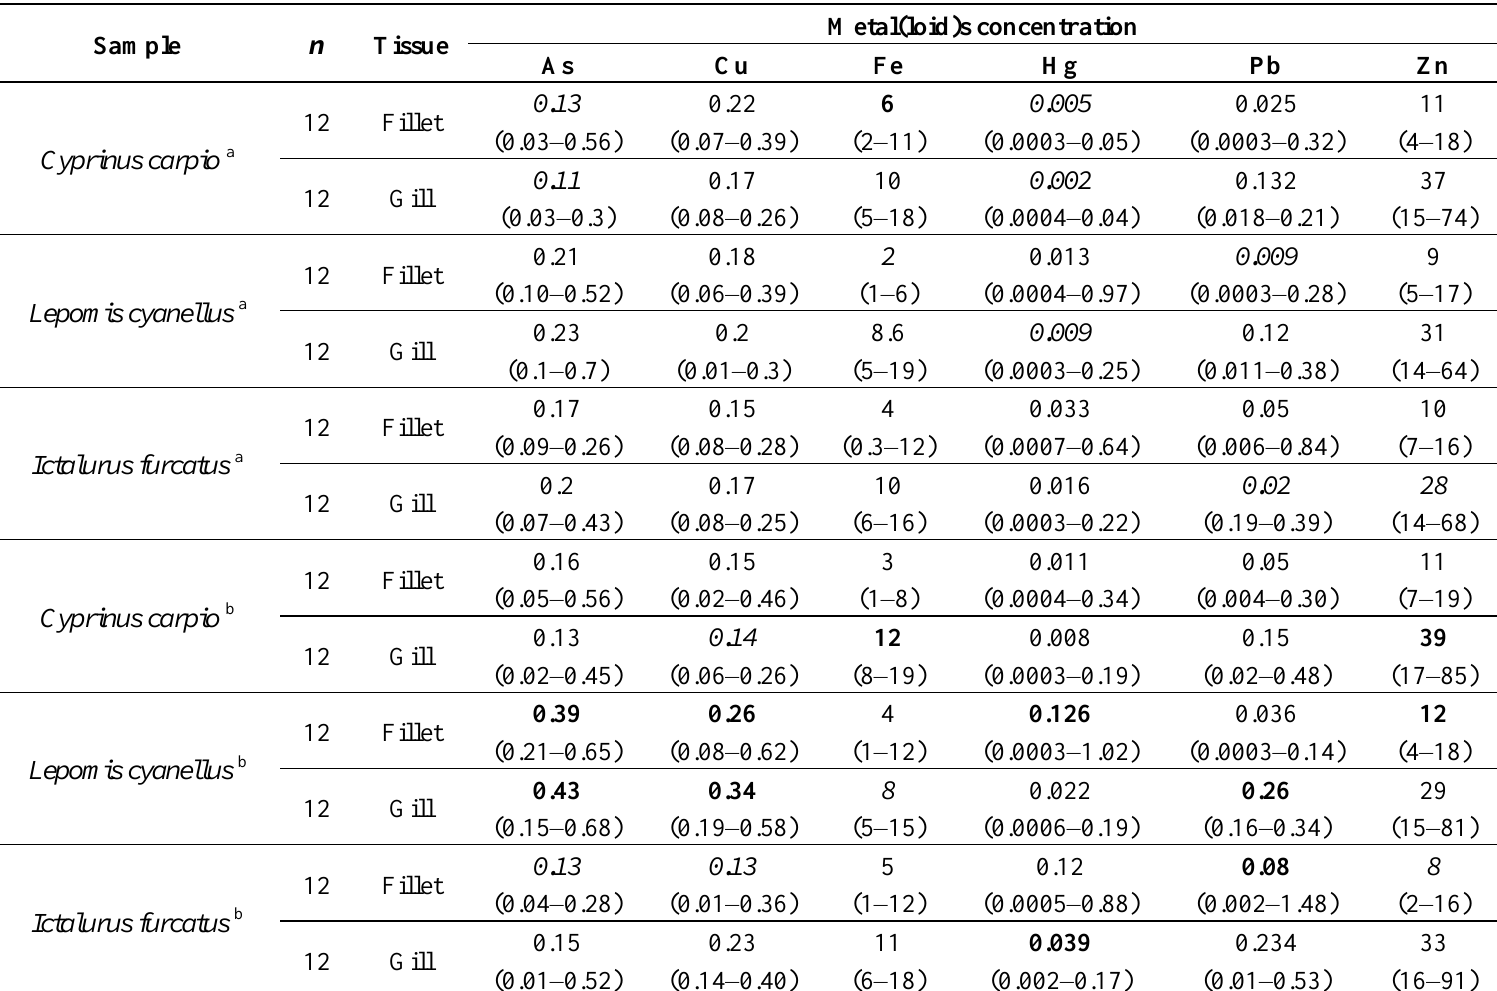
Table A2. Geometric mean values of metal(loid)s concentration for fillet and gills (mg∙kg −1 ww) in fish sampled at Luis L. Leon